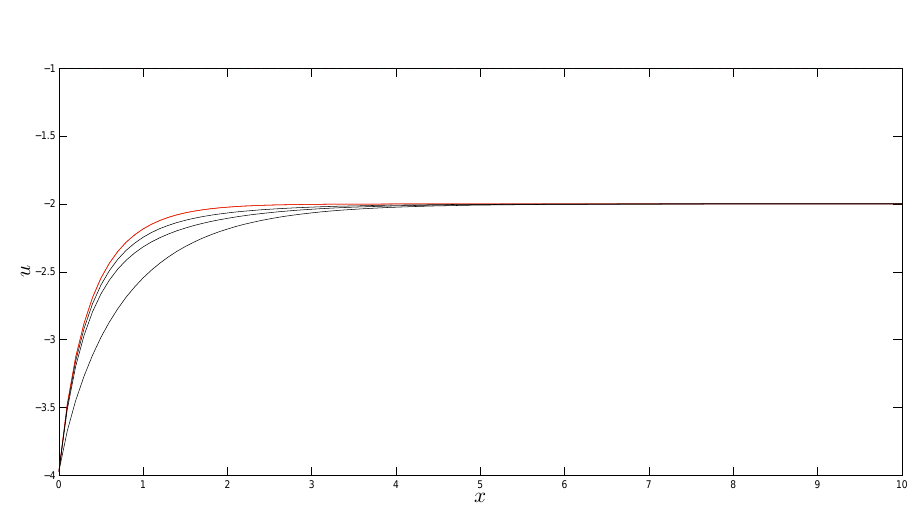
Figure 4: Graph of the numerical solution of QP in the ( x , u = v ) plane for u b = −2 and u + = −1 at times t = 5, 10, 15 and 20 . We note that the exact SS is shown via the red line at t = 20